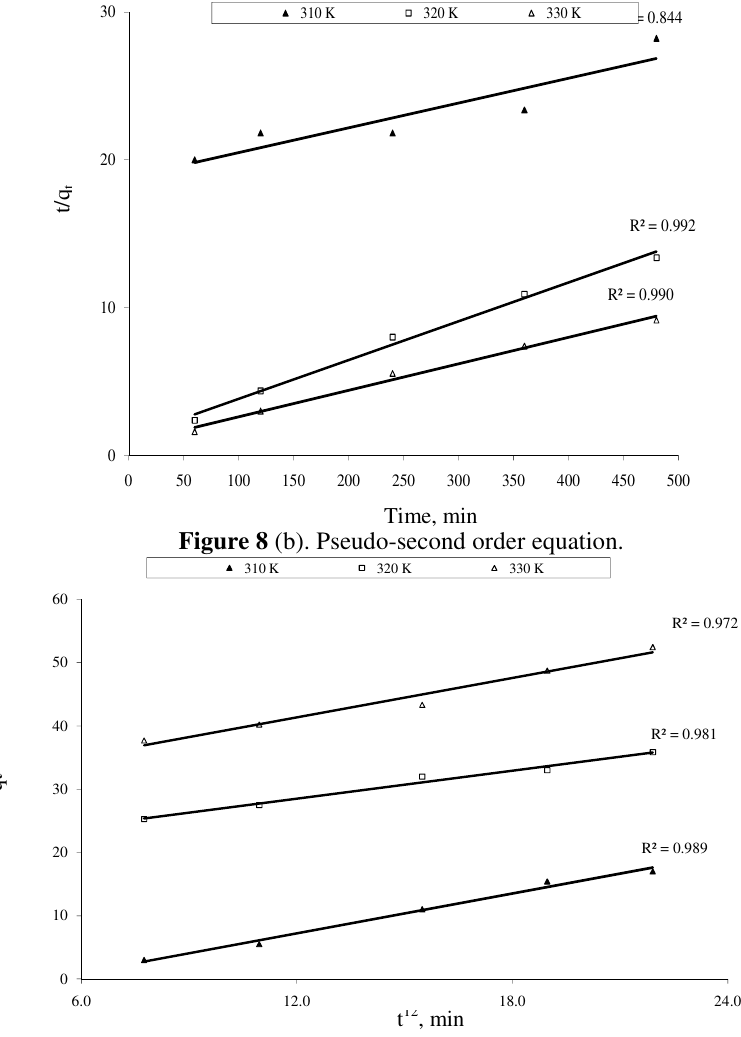
Figure 8 (b). Pseudo-second order equation.